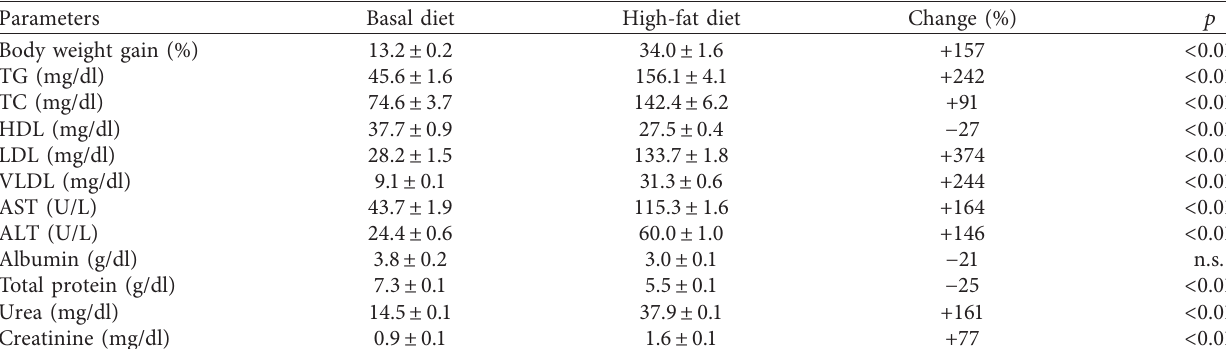
Table 2: Effect of the high-fat diet compared to the basal diet on body weight gain and metabolic parameters in male albino rats.